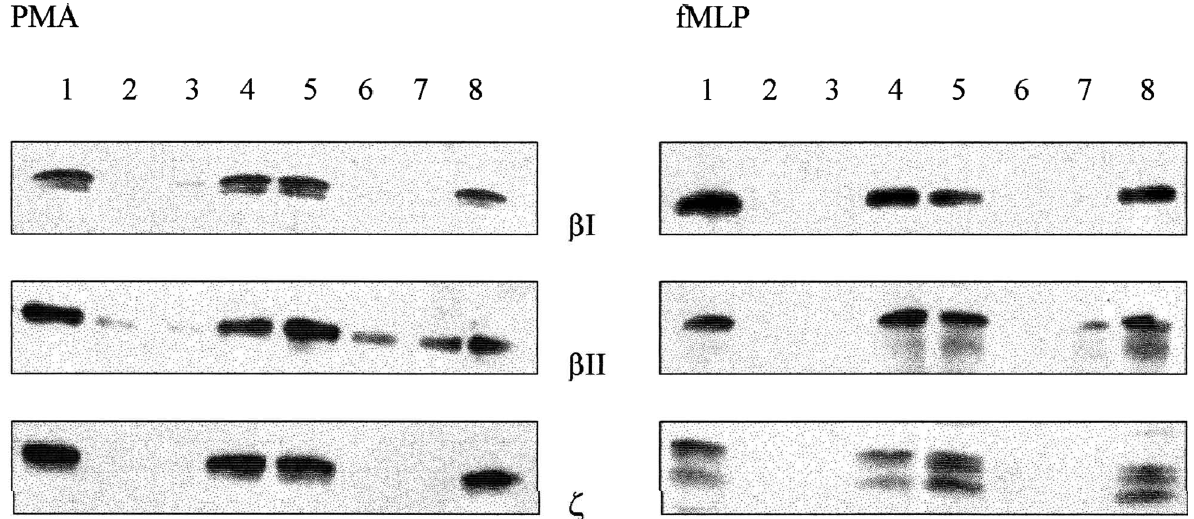
FIG. 4. Action of HA-1077 and Y-32885 on the translocation of PKC. The cells were incubated with the compounds for 15min with different concentrations (0.5 and 10 mM), and the polymorphonuclears were activated by 160nM PMA for 5min at 37°C or by 1 m M fMLP for 10min at 37°C. Lane 1, Cytoplasm of incubated cells with 10 mM HA-1077; lane 2, membrane of incubated cells with 10 mM HA-1077; lane 3, cytoplasm of incubated cells with 0.5 mM HA-1077; lane 4, membrane of incubated cells with 0.5 mM HA-1077; lane 5, cytoplasm of incubated cells with 10 mM Y-32885; lane 6, membrane of incubated cells with 10 mM Y-32885; lane 7, cytoplasm of incubated cells with 0.5 mM Y-32885; lane 8, membrane of incubated cells with 0.5 mM Y-32885. Results are representative of three